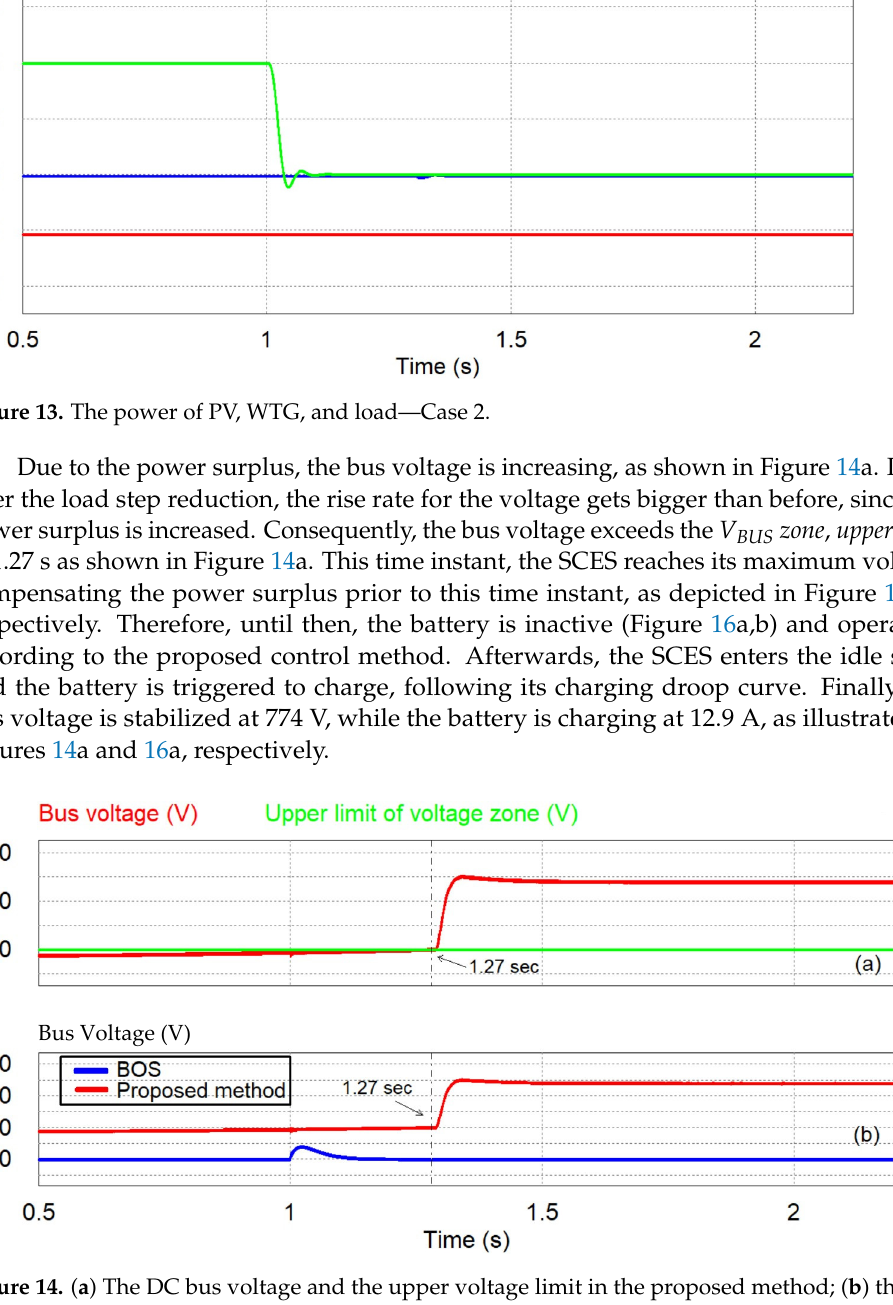
Figure 14. ( a ) The DC bus voltage and the upper voltage limit in the proposed method; ( b ) the DC bus voltage in both methods—Case 2.